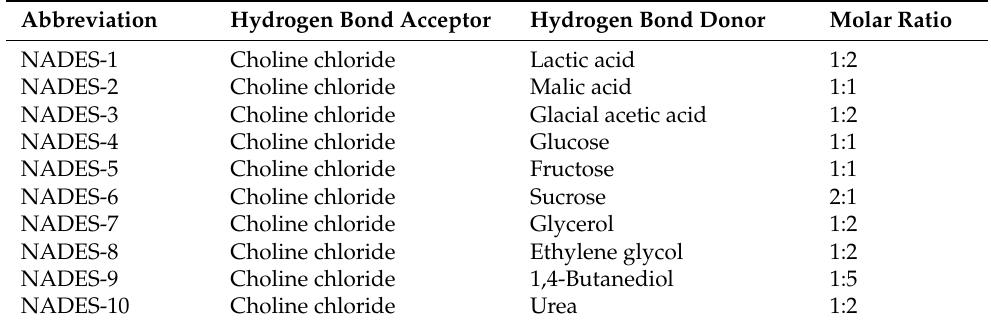
Table 1. Different abbreviations, compositions, and molar ratios of NADESs synthesized in this